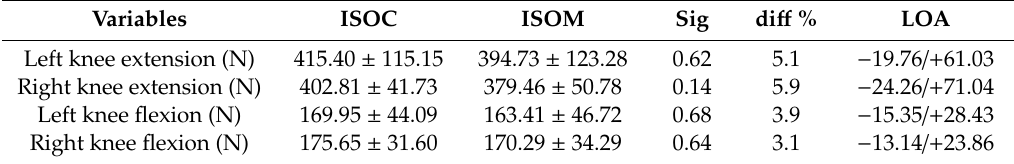
Table 1. Knee extension and flexion peak isometric forces with both devices ( n =